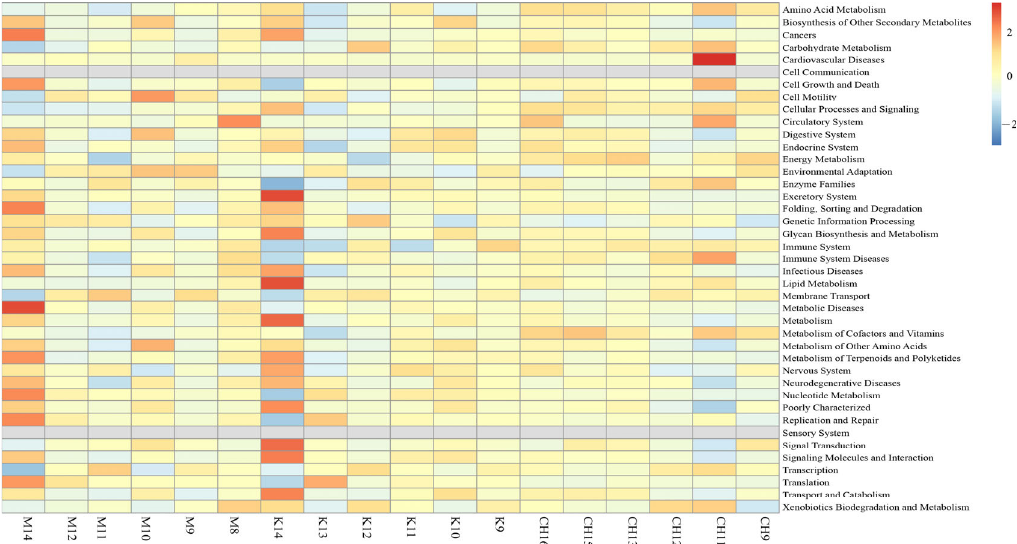
Figure 11. Prediction results of KEGG function of cecum content floras in each group. Note: K refers to the normal control group, CH refers to the CASP intervention group, and M refers to the model group. The same as below.